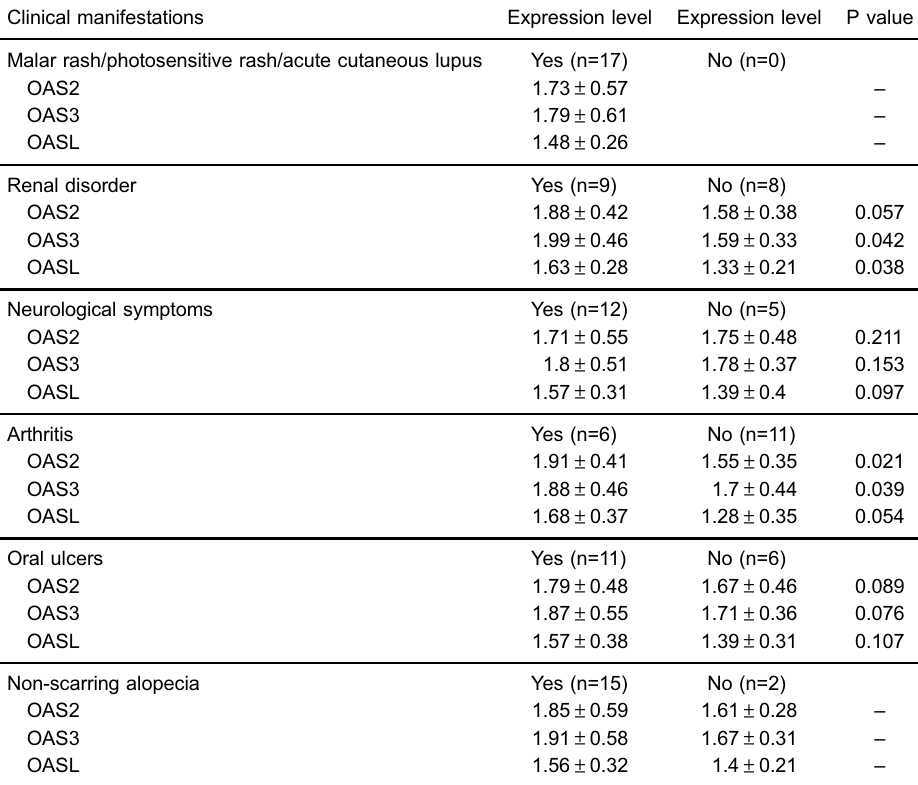
Table 5. Association of OAS2, OAS3, and OASL expression in CD19 + B cells with systemic lupus erythematosus manifestations. Clinical